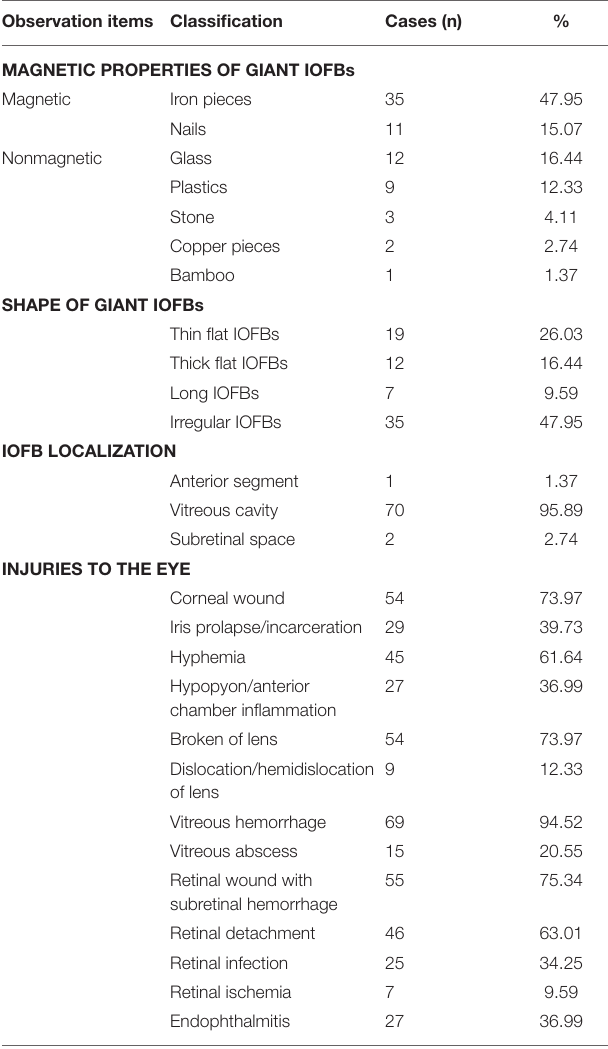
TABLE 1 | Characteristics of giant intraocular foreign bodies (IOFBs) and injuries to the eye. Observation items